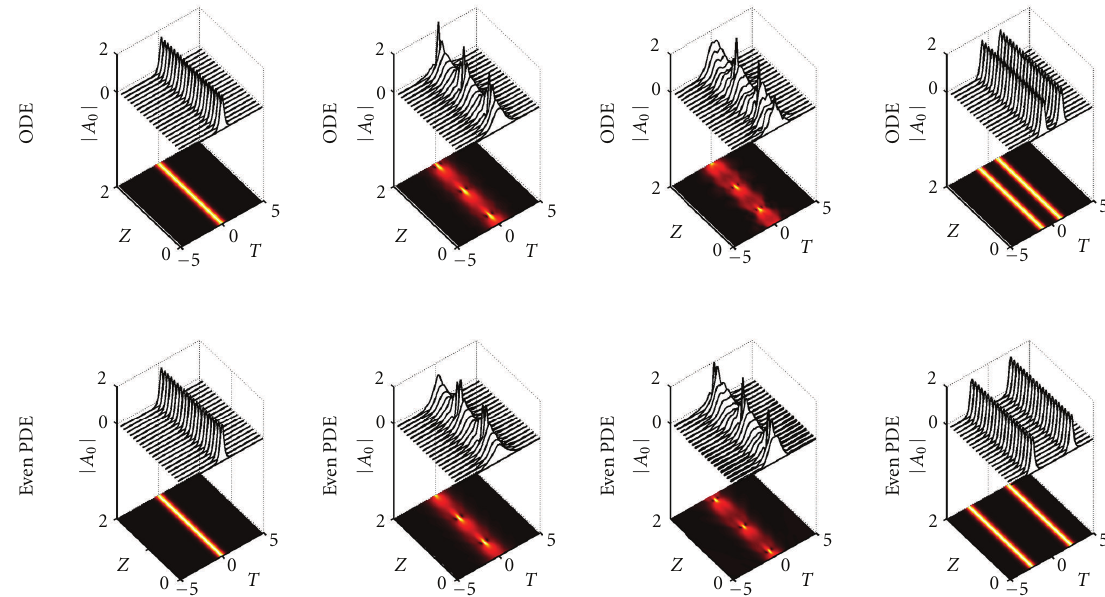
Figure 12: Top: surface and pseudocolor plots of the single-pulse, breather, chaotic, and double-pulse solutions computed for the finite- dimensional model at g 0 = 1 . 5, 2.5, 3.495, and 3.5, respectively. Bottom: the same plots for the even WGAML model taken at g 0 = 2.3, 2.5, 3.1, and 3.2, respectively. The reduced model accurately reproduces the four behaviors observed.